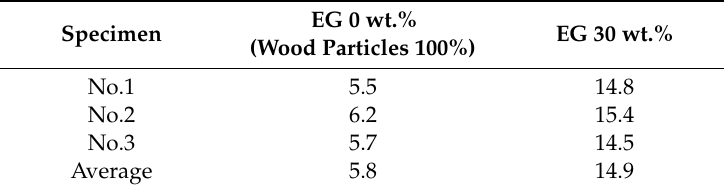
Figure 16. Images of ( a ) before and ( b ) after combustion for smoke toxicity test. Table 4. Result of the time to inactivity of smoke toxicity test (min).